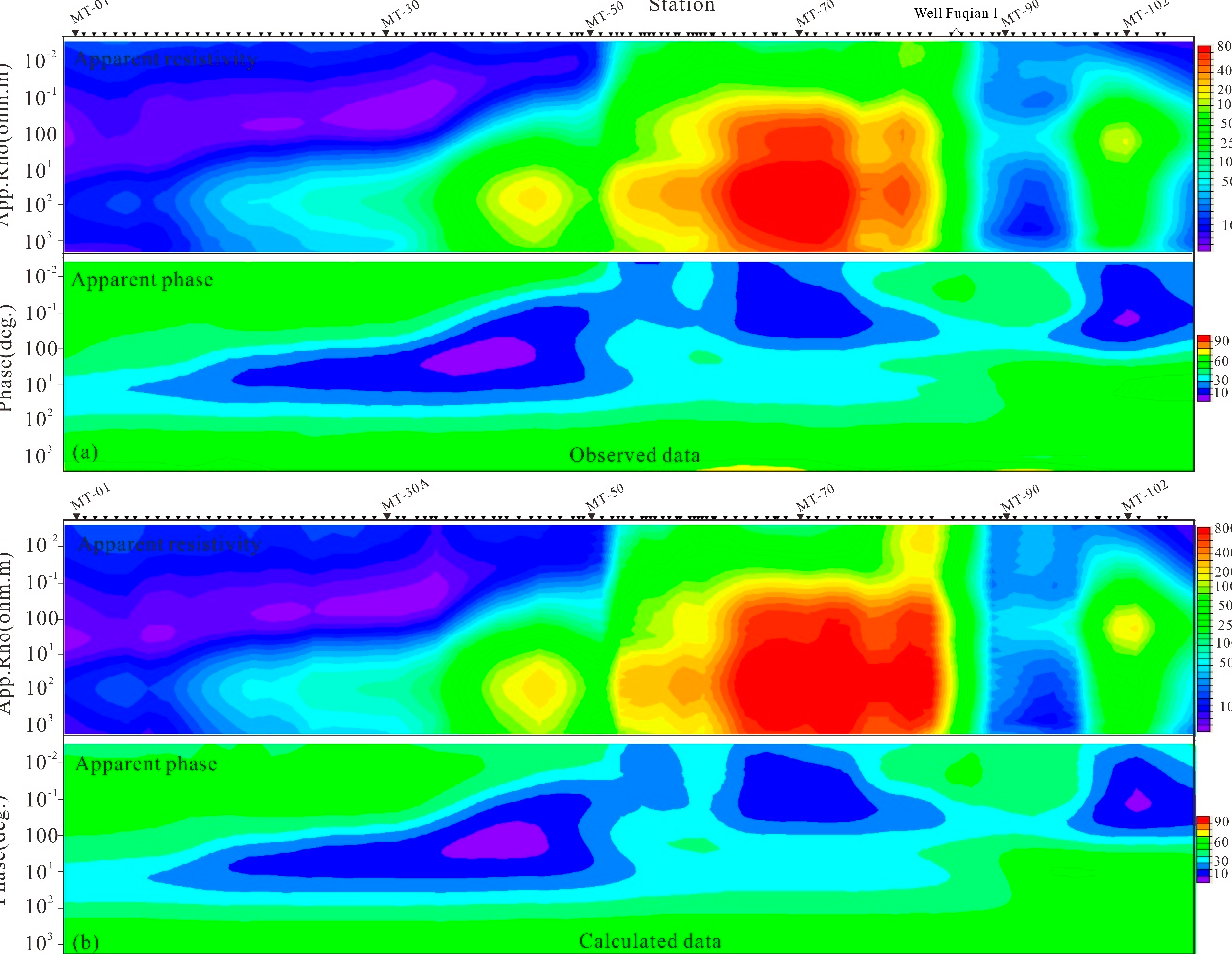
Figure 5. Model roughness and RMS curve (L-curve) obtained by inversion of different regularization.